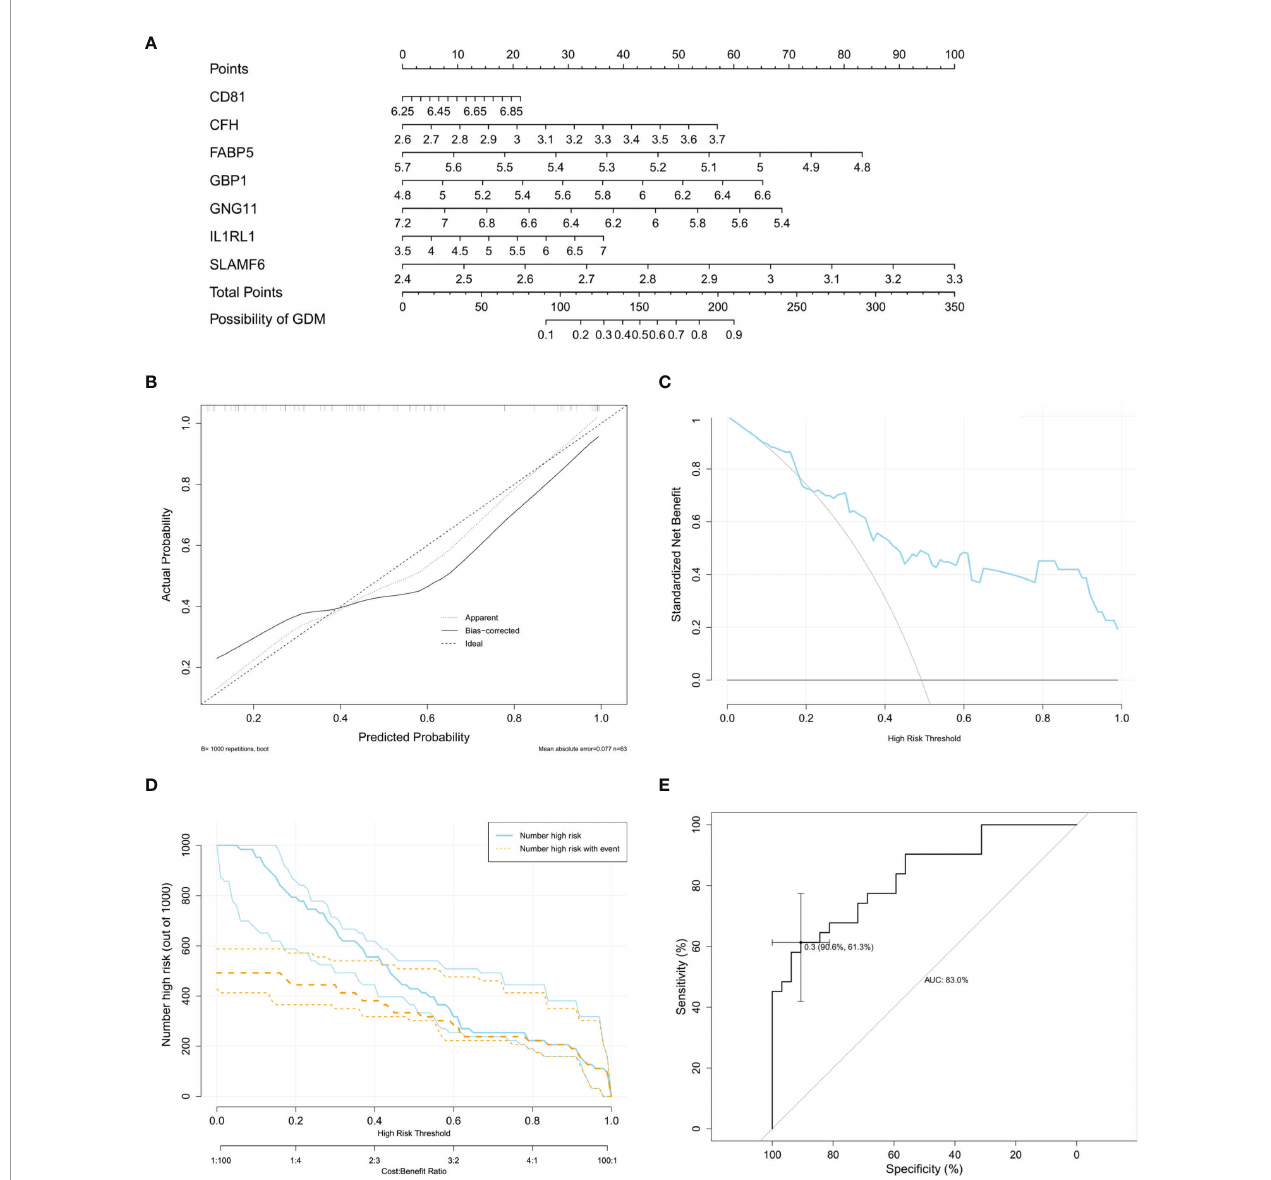
FIGURE 6 | Development and internal validation of a nomogram model for GDM based on GSE70493. (A) Nomogram model for patients with GDM. (B) Calibration curve for predicting possibility of GDM. Decision curve (C) and clinical impact curve (D) for assessing the net bene fi t of the nomogram. (E) ROC curve to assess classifying ability of the nomogram